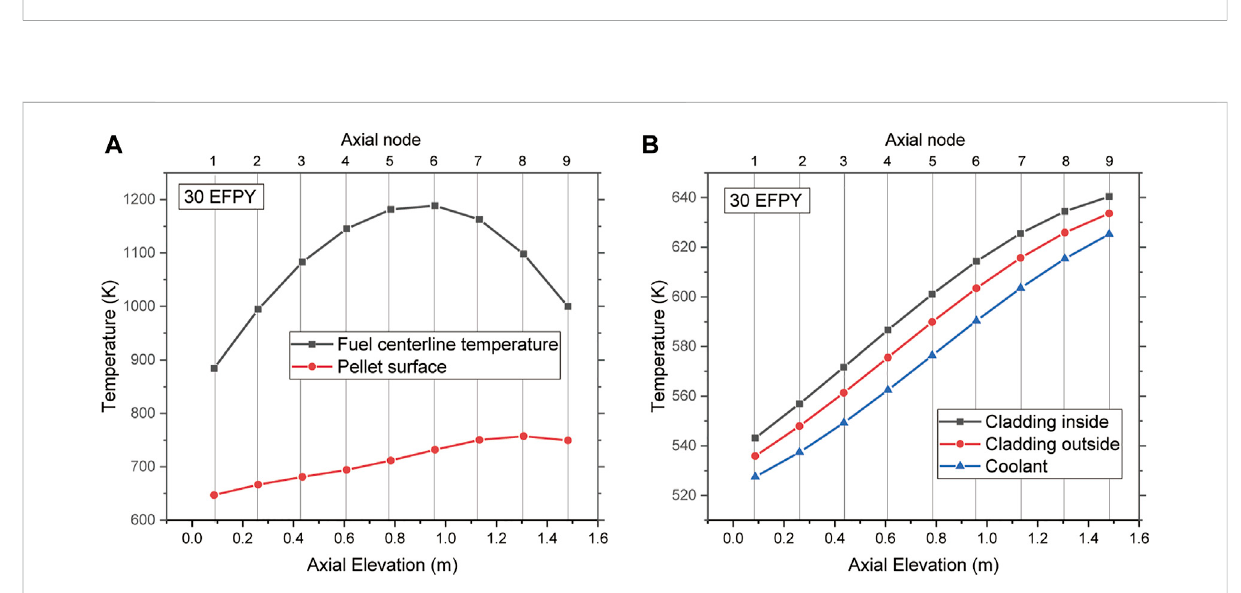
FIGURE 6 End-of-life Temperature of (A) fuel pellet and (B) cladding and